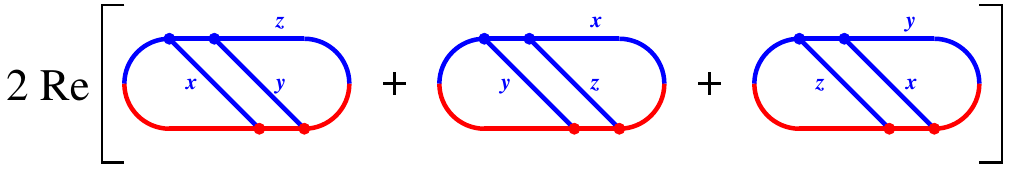
Figure 10 . The sum of diagrams contributing to the total 1 /N 2 correction to the total sequential diagram rate. Note that exchanging the daughters y ↔ z in the first diagram does not generate a additional diagram if all possible color transition possibilities have already been included in the evaluation of each